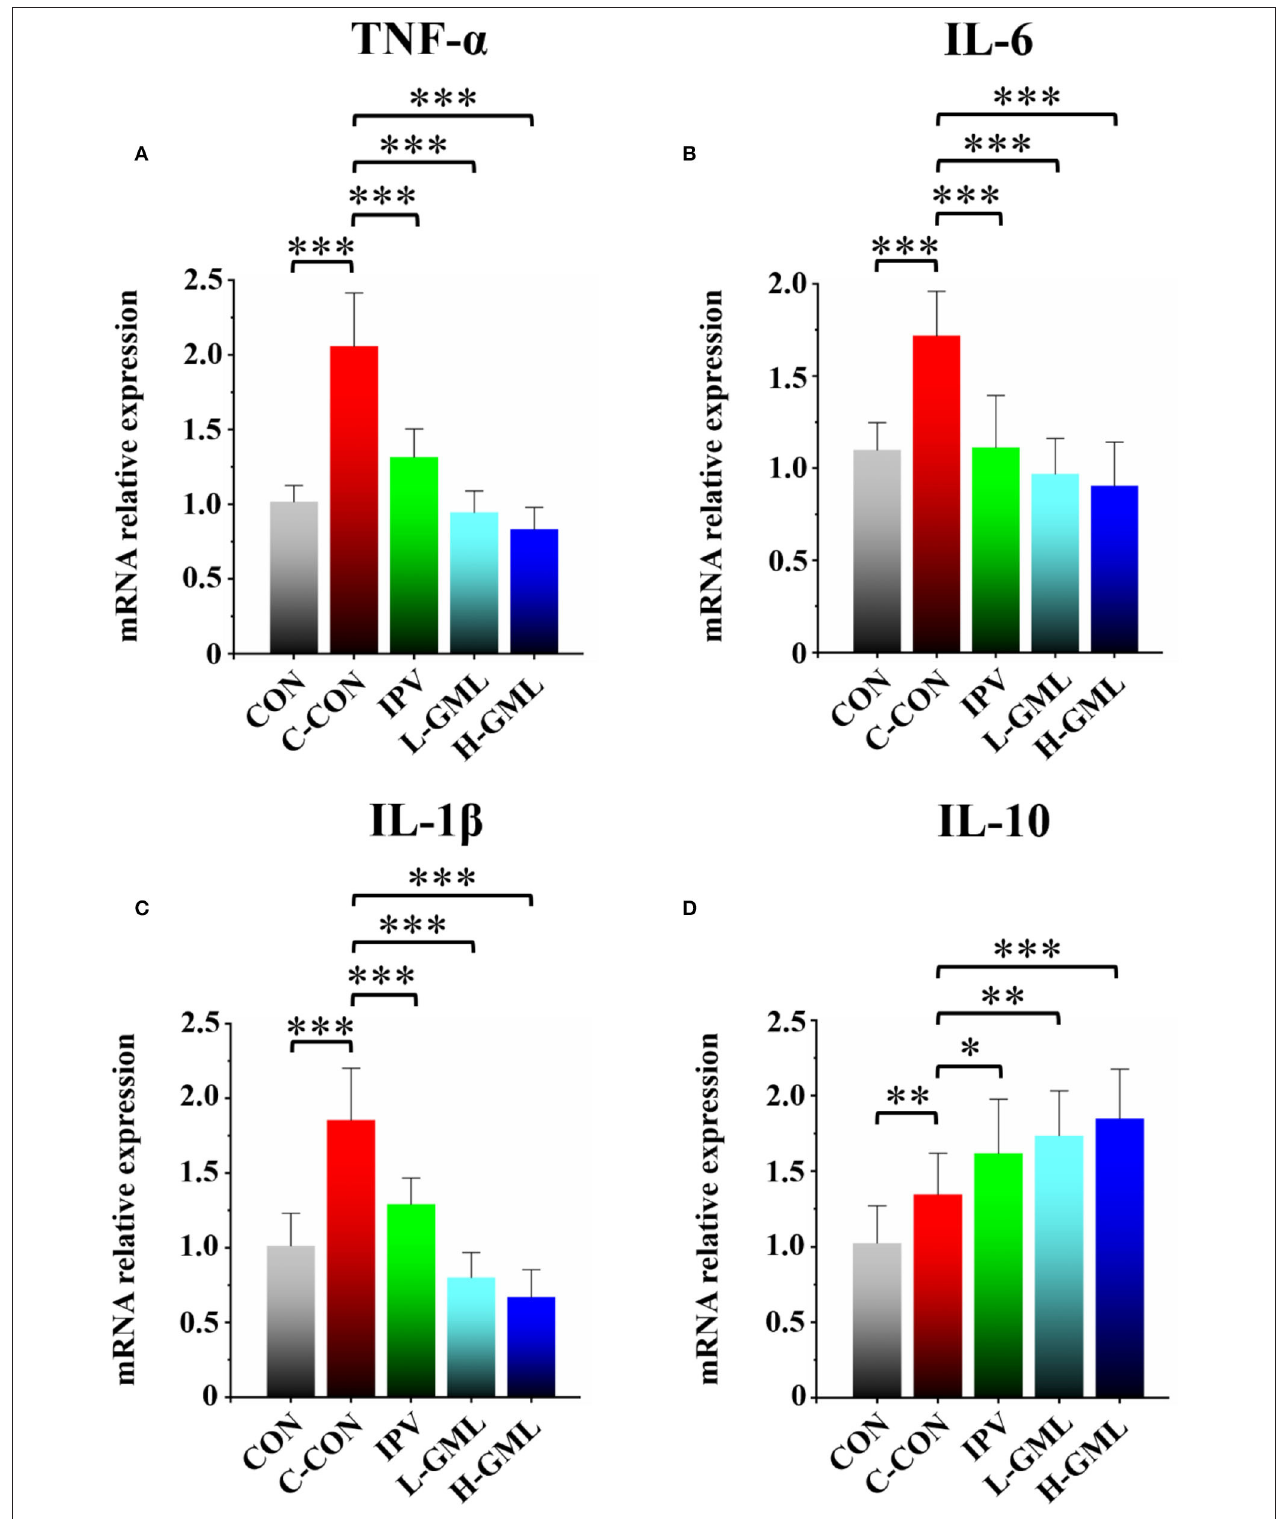
FIGURE 4 | Cytokine (A) TNF- α , (B) IL-6, (C) IL-1 β , and (D) IL-10 level of the superficial inguinal lymph nodes of experimental pigs. Dissimilar numbers of stars represent significant differences (*: p < 0.05, **: p < 0.01, ***: p < 0.001).